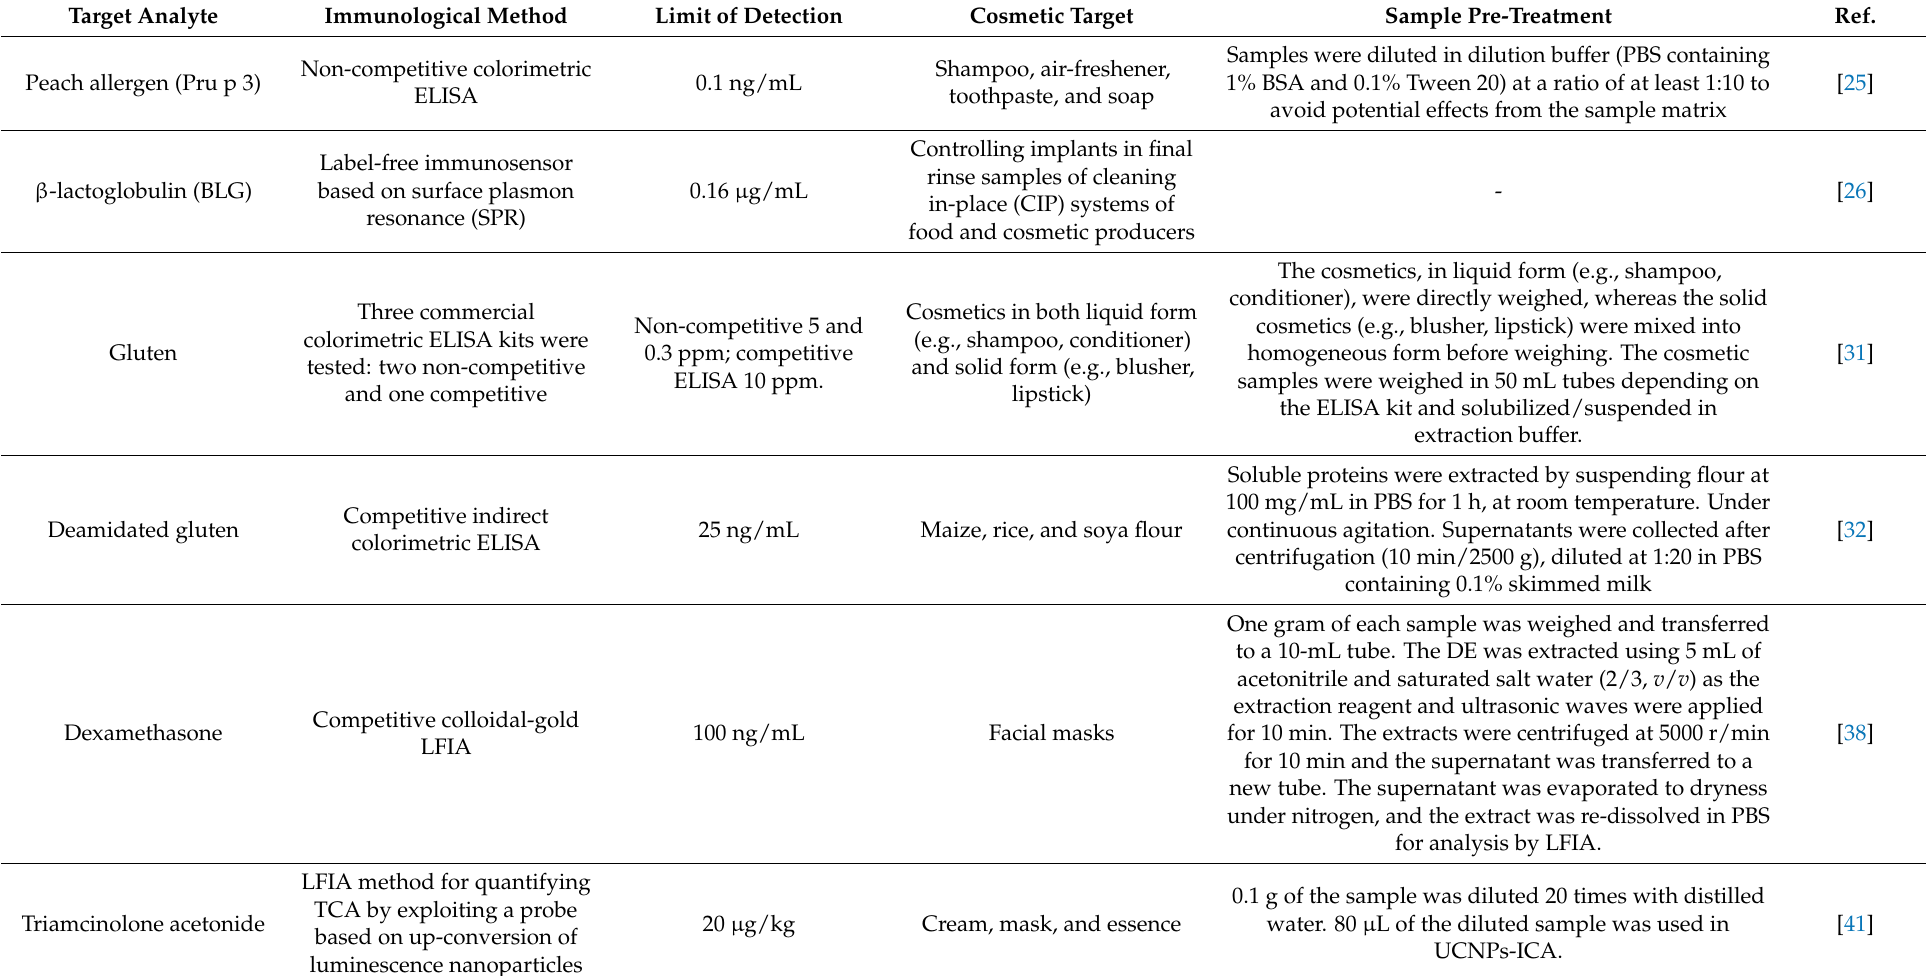
Table 1. Summary of the immunological methods applied on cosmetic products proposed in the